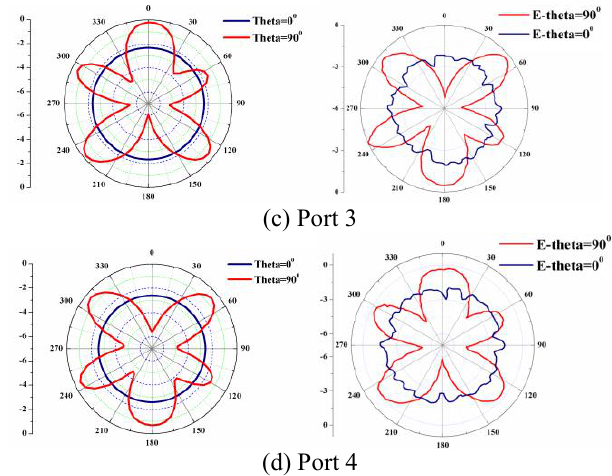
Figure 8: Simulated (Left side) Measured (Right side) 2D Radiation patterns of the pattern diversity antenna in Elevation plane with excitations at different ports at